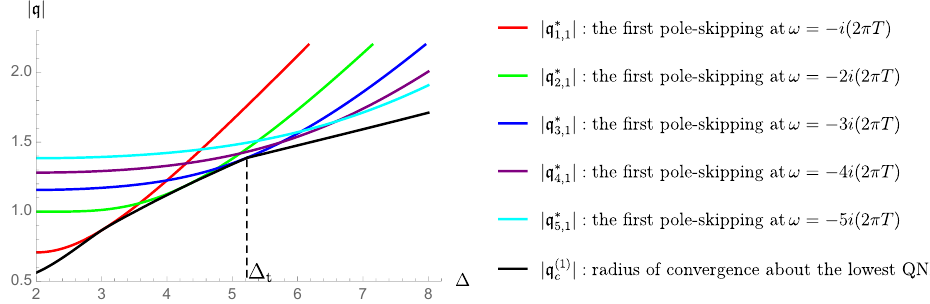
Figure 8 . Comparison between the radius of convergence of the derivative expansion about the lowest-lying gapped QNM, determined by | q (1) c | , and the smallest absolute value of the momentum at pole-skipping points. The red, green and blue curves can be continued to larger values of ∆ , but here we focus on the lower values of | q | . Higher QNMs with n = 4 , 5 have been considered and do not intersect or coincide with the black line of | q (1) c | -values in the range 2 ≤ ∆ ≤ 8